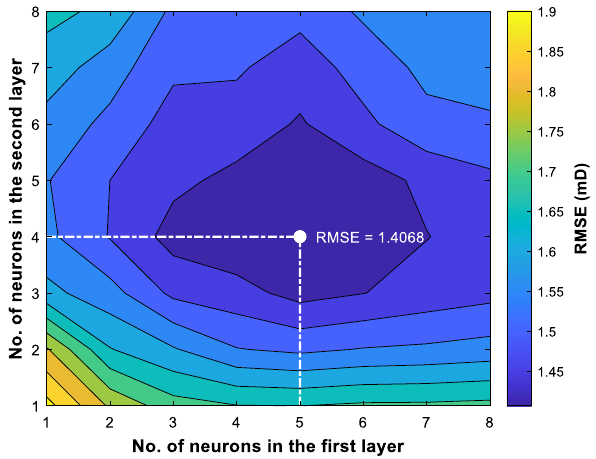
Fig. 6 Variations of RMSE with the number of neurons in the first and second layers of the MLP NN